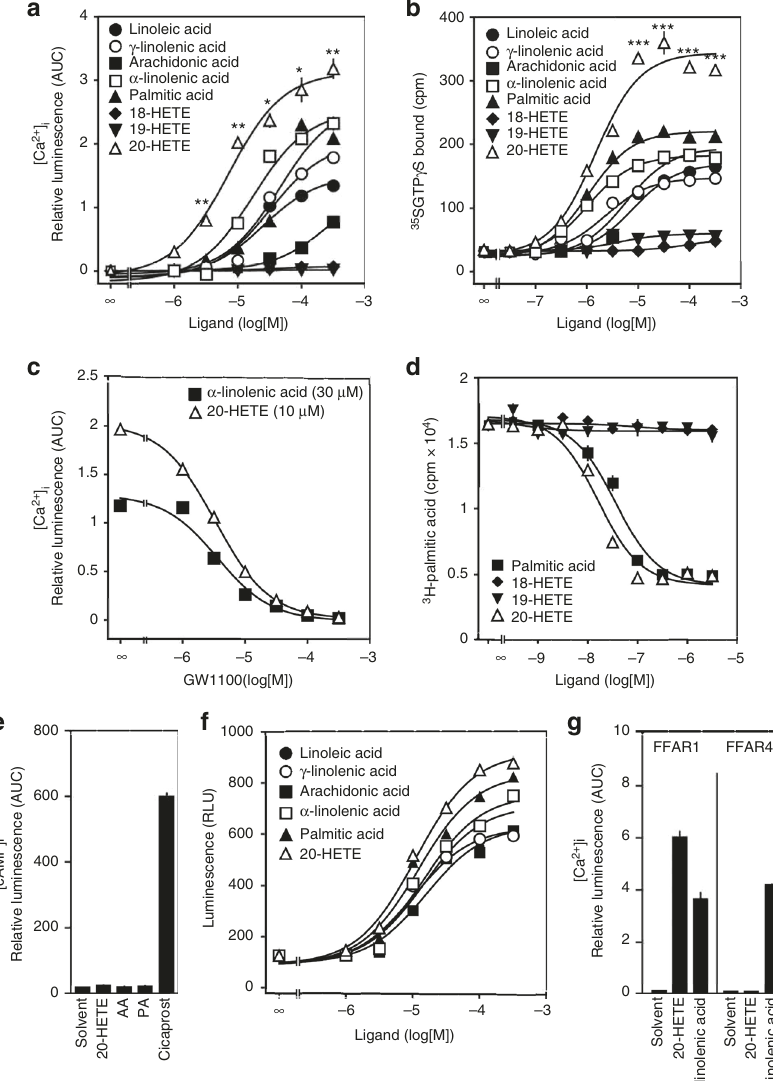
Fig. 1 20-HETE is a full agonist of FFAR1. a Effect of increasing concentrations of the indicated lipids on [Ca 2+ ] i in COS-1 cells transfected with cDNA encoding FFAR1 together with a Ca 2+ -sensitive bioluminescent fusion protein (G5A). b Effect of increasing concentrations of the indicated lipids on 35 S- GTP γ S binding to membranes prepared from COS-1 cells expressing FFAR1. c Effect of increasing concentrations of the FFAR1 antagonist GW1100 on 20- HETE- and α -linolenic acid-induced increase in [Ca 2+ ] i in COS-1 cells. d 3 H-palmitic acid competition binding study with FFAR1 expressed by COS-1 cells. Competition with unlabeled palmitic acid ( fi lled squares) and the indicated lipids is shown. e Effect of 30 μ M 20-HETE and related lipids (arachidonic acid (AA) and palmitic acid (PA)) on intracellular cAMP levels in COS-1 cells expressing FFAR1 and a cAMP-sensitive bioluminescence probe. As control, COS- 1 cells transfected with prostacyclin receptor (IP) were exposed to 1 μ M cicaprost (right column). f Effect of increasing concentrations of the indicated lipids on β -arrestin recruitment to FFAR1 using the TANGO assay system as described in Material and Methods. g Effect of 20-HETE (30 µ M) on FFAR1 and FFAR4 heterologously expressed in COS-1 cells together with a cytosolic Ca 2+ -sensitive bioluminescence probe (G5A) as described in Material and Methods. Functionality of the receptors was assessed by exposure to the known agonists α -linolenic or linoleic acid (30 μ M). Shown are mean values ± s.e. m., n = 9, * P ≤ 0.05; ** P ≤ 0.01 (compared to α -linolenic acid ( a )); *** P ≤ 0.001 (compared to palmitic acid ( b )) (Student ’ s two-tailed t